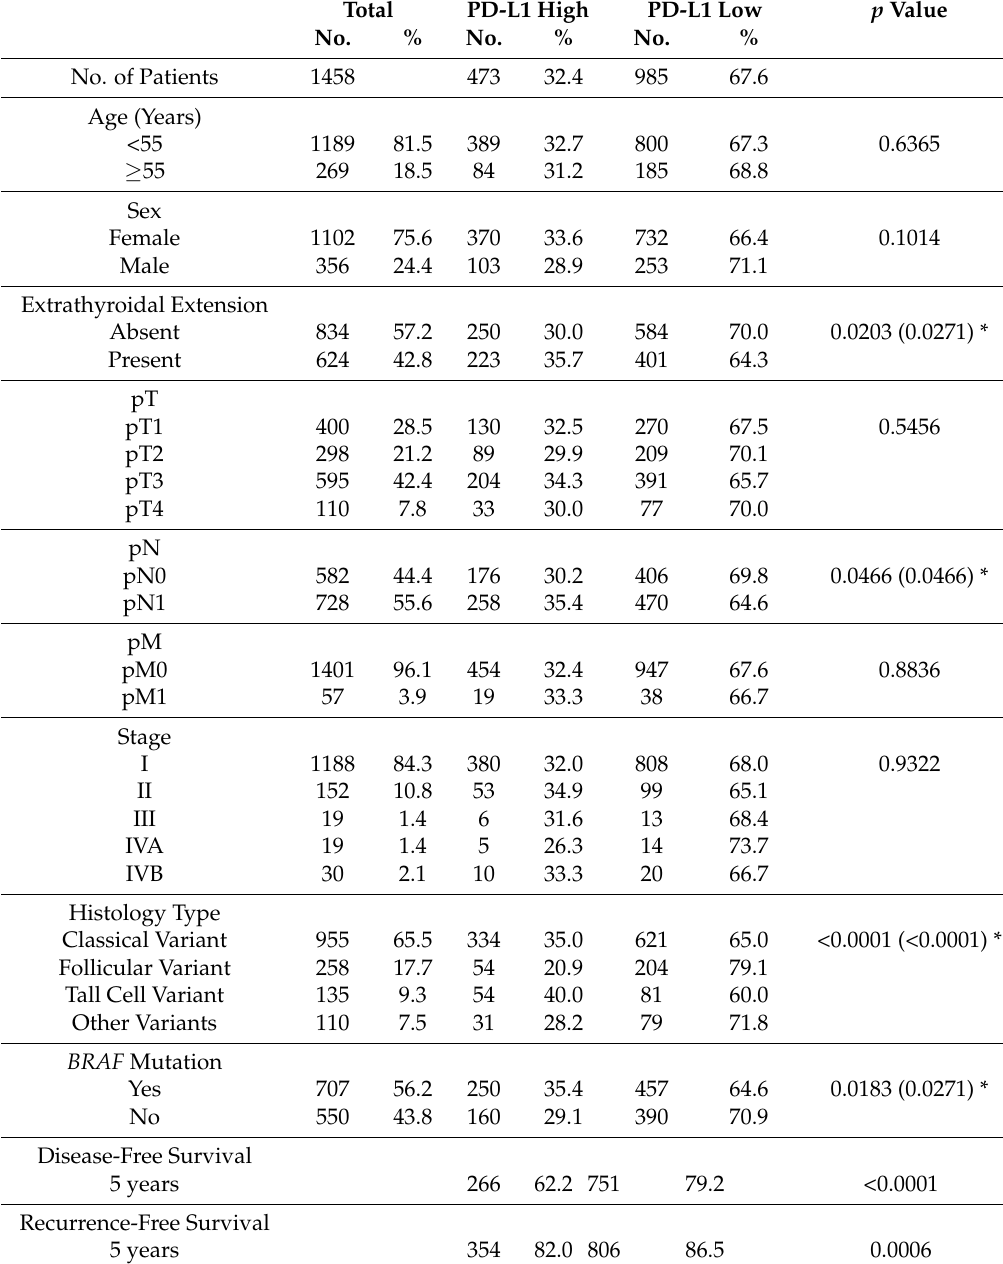
Table 1. Association of clinico-pathological characteristics with PD-L1 expression in papillary thyroid